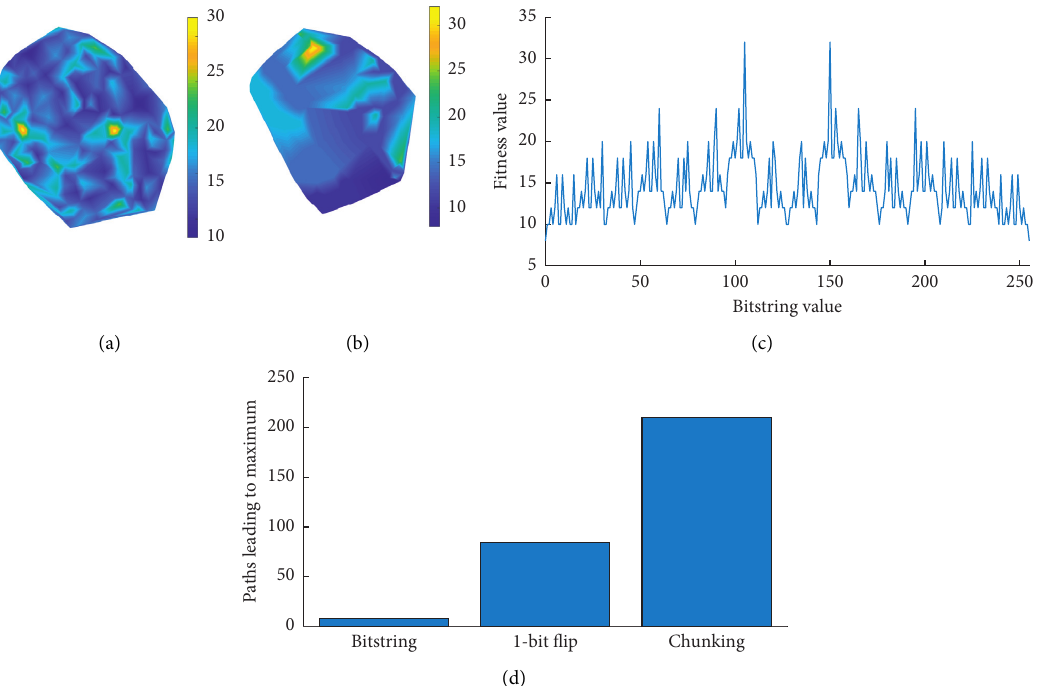
Figure 3: Same function (H-XOR, N � 8) mapped with three different definitions of the neighborhood. (a) 1-bit flip representation. (b) Chunking algorithm representation. (c) Bitstring representation in a decimal system (see Figure 2 for explanation of bitstrings). (d) Comparative performance of bitstring (c), 1-bit flip (a), and chunking algorithm